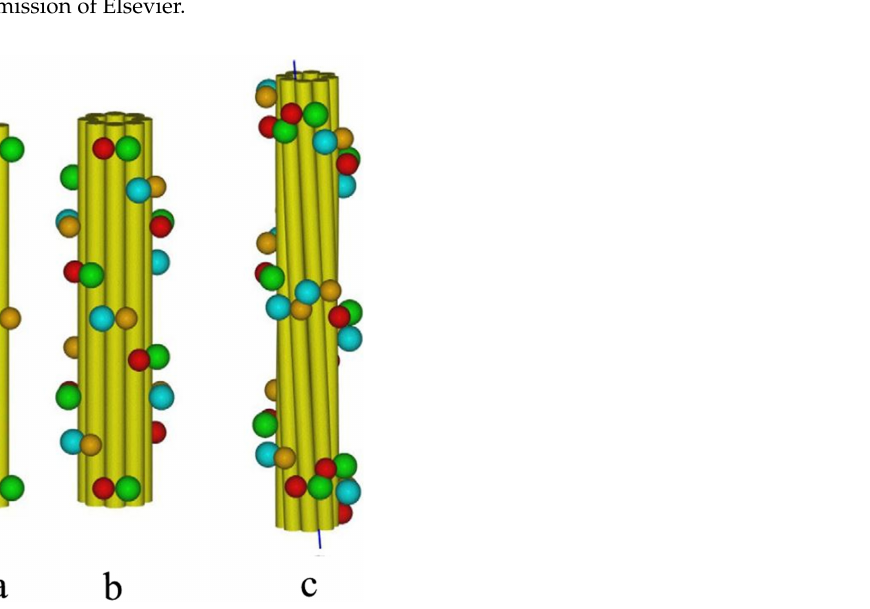
Figure 12. Models of ( a ) a single protofilament in the reduced state, ( b ) the reduced IF with eight protofilaments arranged on a ring of radius 3.5 nm, and ( c ) the oxidized IF, again with eight proto- filaments, arranged on a ring of radius 3.0 nm. The yellow cylinders represent the rod domain of the IF molecules, whereas the spheres represent the terminal domains: green = both heads of the Up strands, red = both tails of the Up strands, blue = both heads of the Down strands, and orange = both tails of the Down strands. In ( b ) the terminal domains in the reduced structure are arranged on a two-start left-handed helix, thereby giving rise to a diagonal banding with a spacing of 22 nm. In contrast, in ( c ) the terminal domains in the oxidized structure with its dislocated lattice lie on a one-start helix of pitch length 23.5 nm. Figure reproduced from [97] with permission of Springer. Scanning transmission electron microscopy (STEM) has indicated that trichocyte keratin IF contain about 32 chains in cross-section [96]. This would be consistent with the formation of eight protofilaments in the filament and each of these would contain four chains in section, i.e., two molecules. Using the crosslinking data and the modes of asso- ciation that these infer, together, with X-ray diffraction data, it is possible to find a surface lattice structure for the KIF in the reduced and oxidized states. These are defined by the axial repeat distances, the axial projections of the surface lattice lengths a and b ( z a and z b , respectively), and the angular projections of each length ( t a and t b , respectively) measured around the filament axis. Physically, z a corresponds to the axial distance between consec- utive surface lattice points and z b to the axial stagger between adjacent protofilaments. The reduced lattice structure is given by an axial repeat of 44.92 nm, z a = 11.23 nm, t a = − 90°, z b = 16.85 nm, and t b = +45° [101]. The oxidized surface lattice, after it has undergone